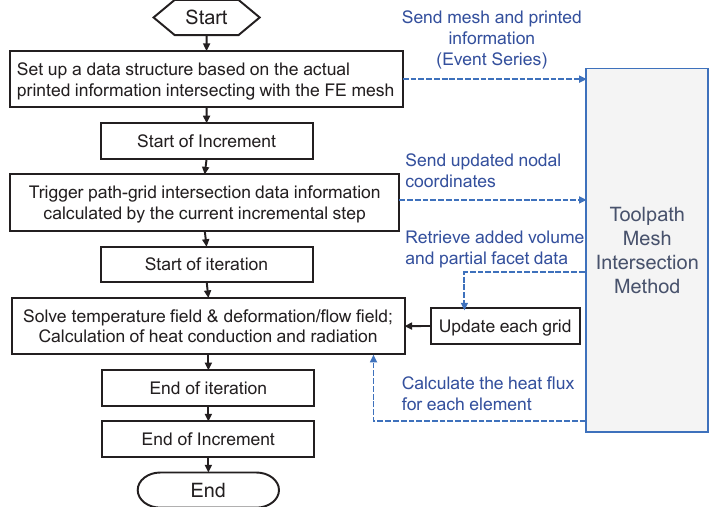
Figure 4. Schematic diagram of the toolpath-mesh intersection Method in SLM